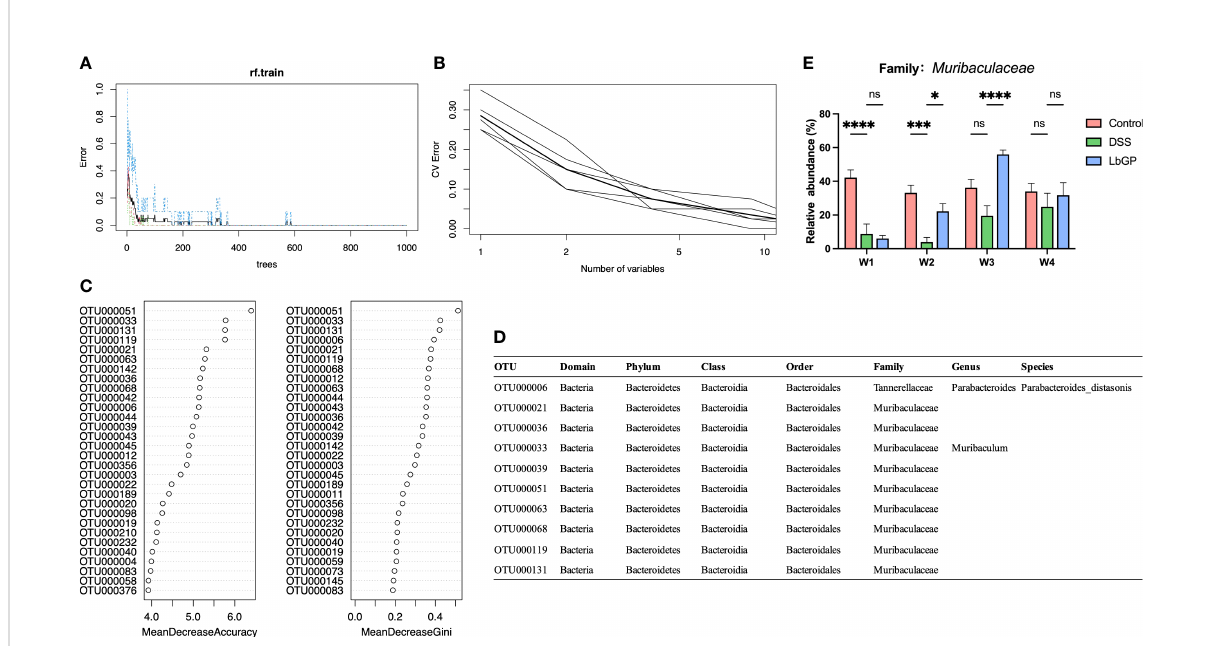
FIGURE 6 Identi fi cation of key OTU using Random Forest classi fi cation. (A) Error rates of the Random Forest model. (B) Error rates of 10-fold cross validation with 5 trials. (C) The mean decrease accuracy and mean decrease Gini of the top 20 OTUs in the Random Forest model. (D) Detailed taxonomy of the top 10 OTUs in the Random Forest model. (E) Relative abundance of Muribaculaceae (n = 5, *P < 0.05, ***P < 0.0005, ****P < 0.0001). “ ns ” means “ no signi fi cant ”